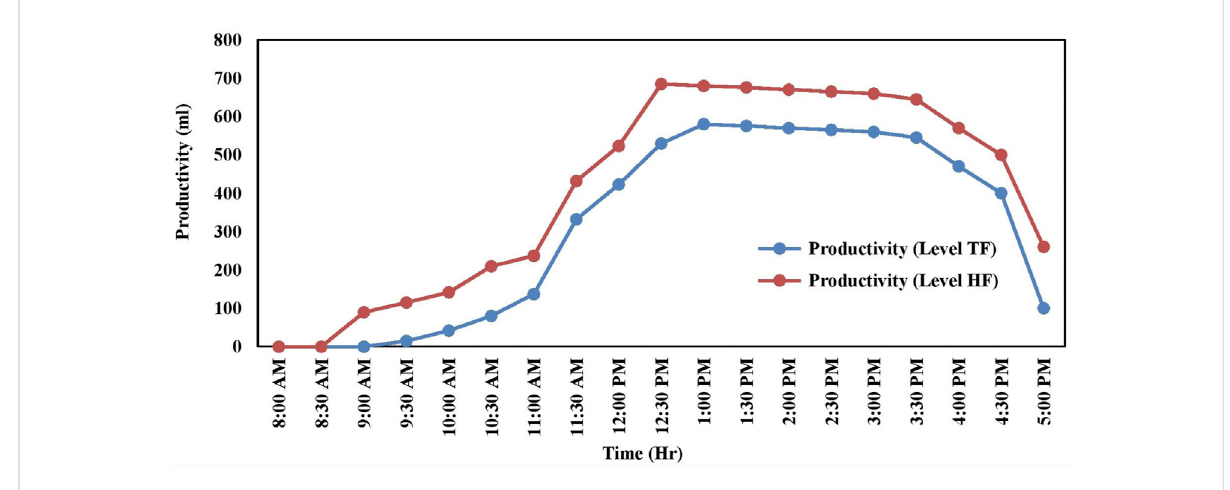
FIGURE 6 Productivity of distilled water with